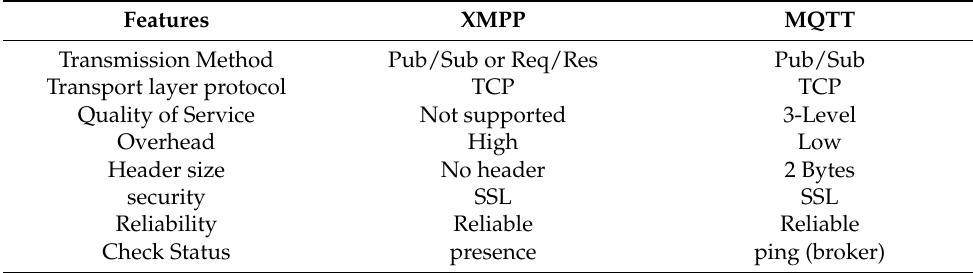
Table 1. Features of the MQTT and the